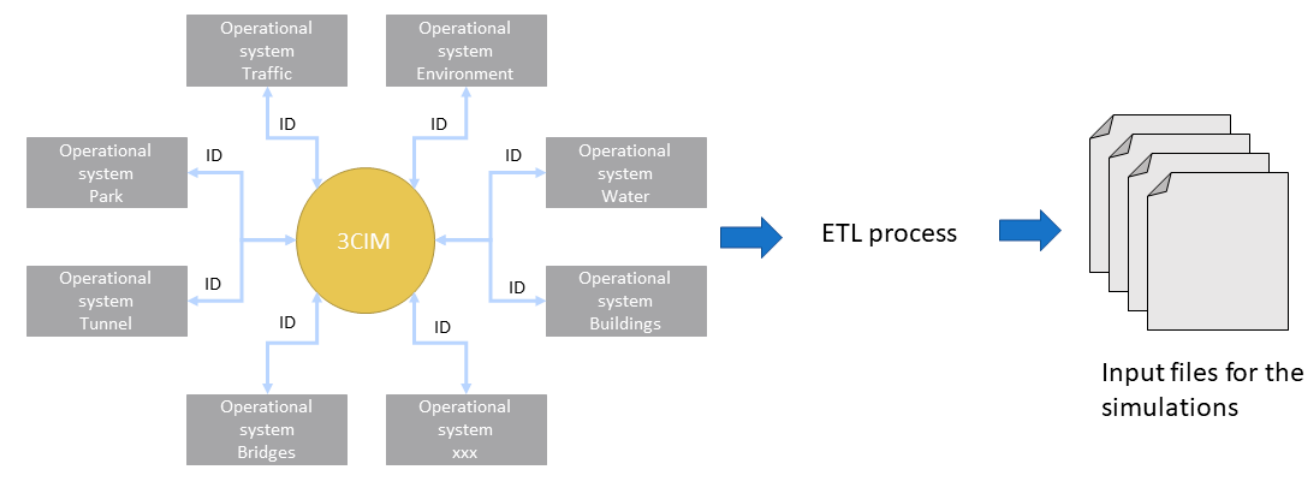
Figure 4. As 3CIM connects to external databases/operational systems, this approach requires a process to generate input data to applications (e.g., simulations). ETL: extract, transform, and load.